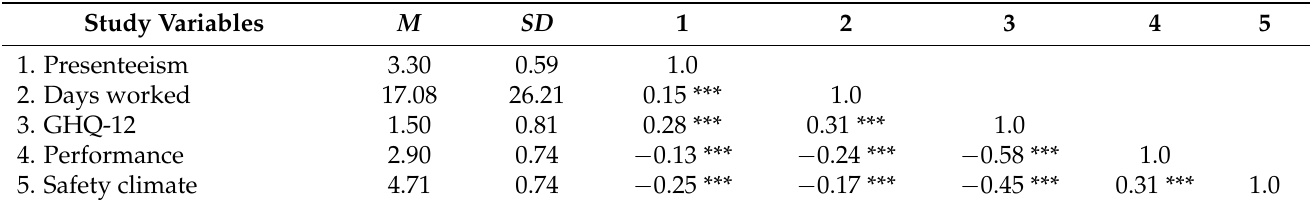
Table 2. Correlations between study variables.